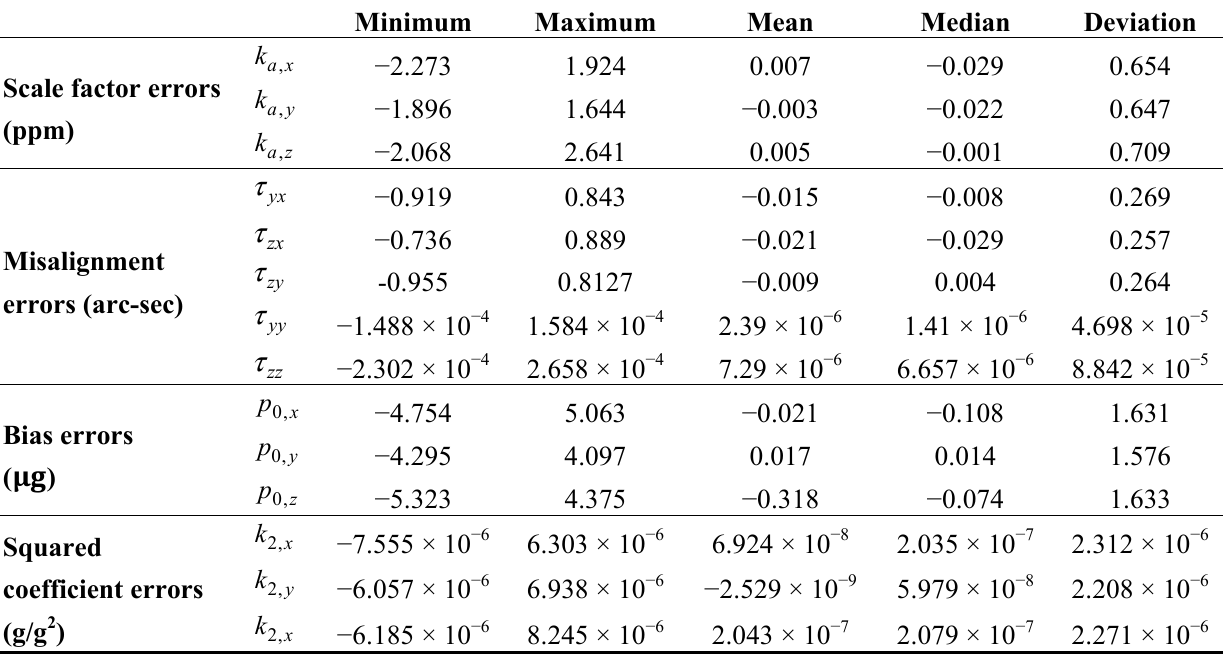
Table 4. Calibration results of 500 Monte Carlo simulations for triaxial